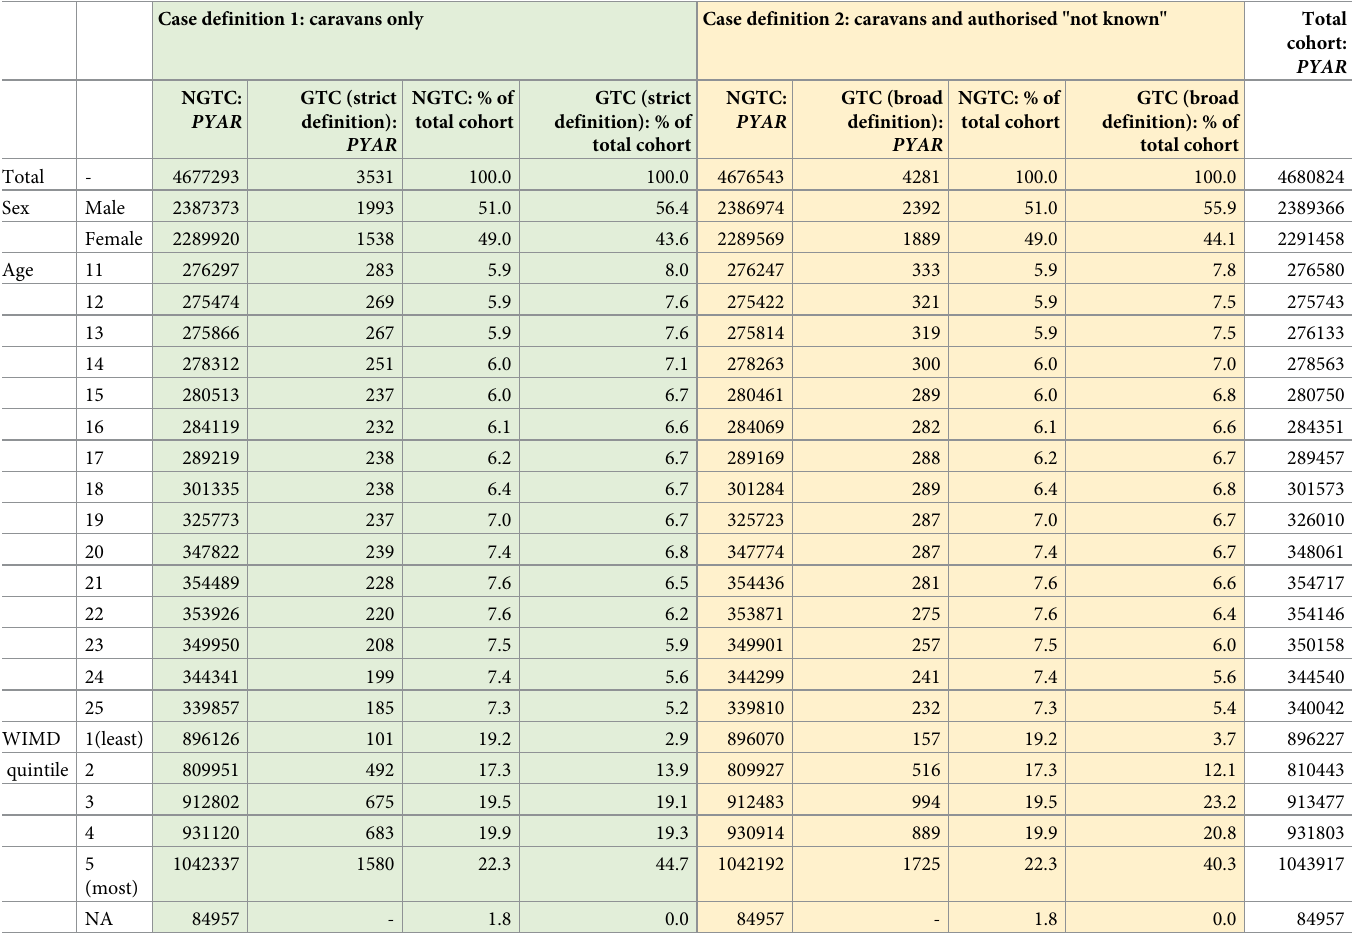
Table 3. Study population by study cohort, sex, age and deprivation quintile (counts are PYAR, not individuals). Case definition 1: caravans